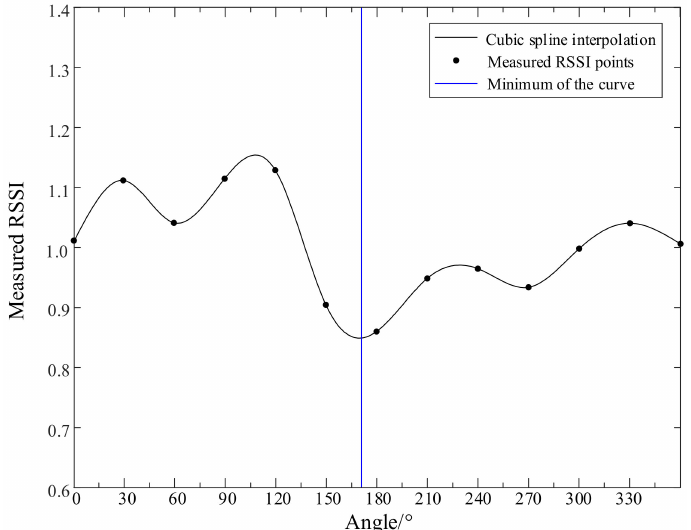
Figure 13. Diagram of cubic spline